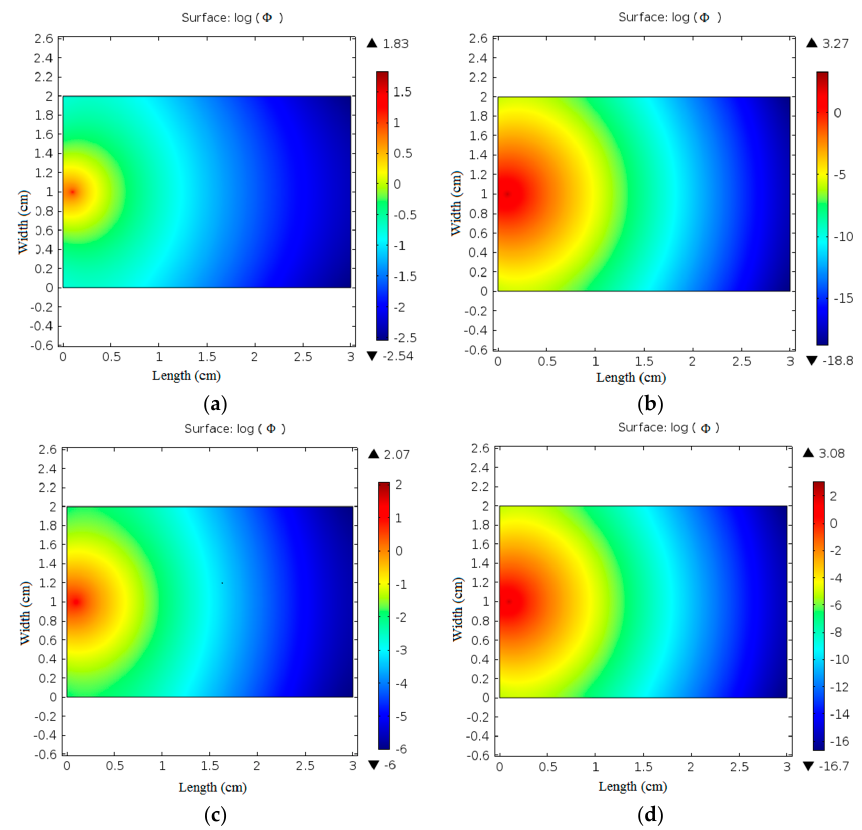
Figure 6. Fluence rate at tissue samples surface: ( a ) normal chicken liver at 635 nm; ( b ) coagulated chicken liver at 635 nm; ( c ) normal chicken liver at 808 nm; ( d ) coagulated chicken liver at 808 nm laser irradiation.